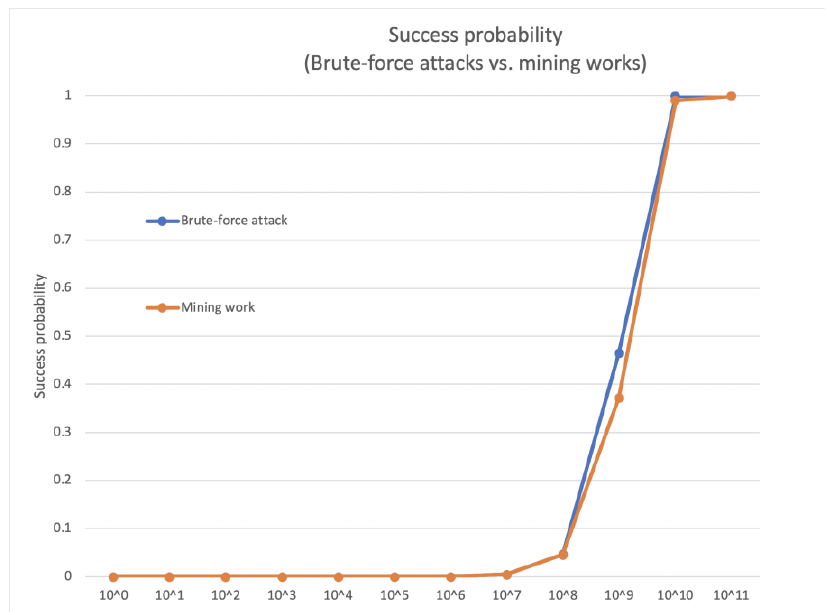
Figure 15. Brute-force attack vs. mining works.